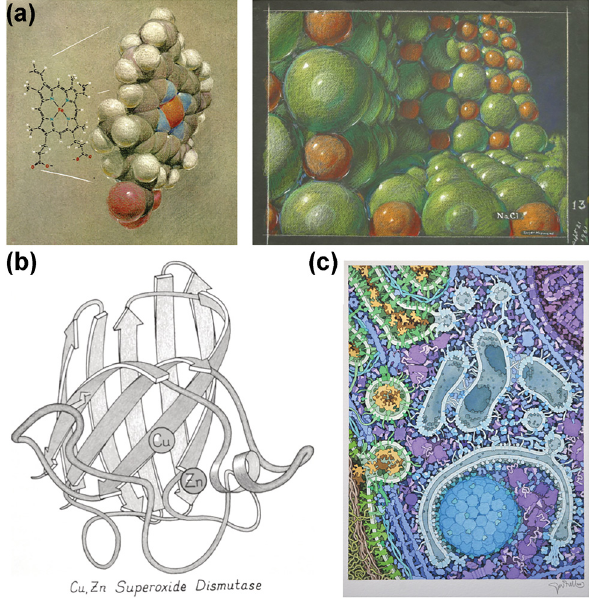
Figure 1: Molecular drawings. (a) Pastel drawings by Roger Hayward of a hemoglobin heme group (1964) or a NaCl crystal (1961) made during his collaboration with Linus Pauling (Special collections & Archives research Center, Oregon state College). (b) Ribbon drawing by Jane Richardson highlighting the beta strands in a protein (1981) [49, 50]. (c) Formation of an autophagosome illustrated by David S. Goodsell, in collaboration with Daniel Klionsky